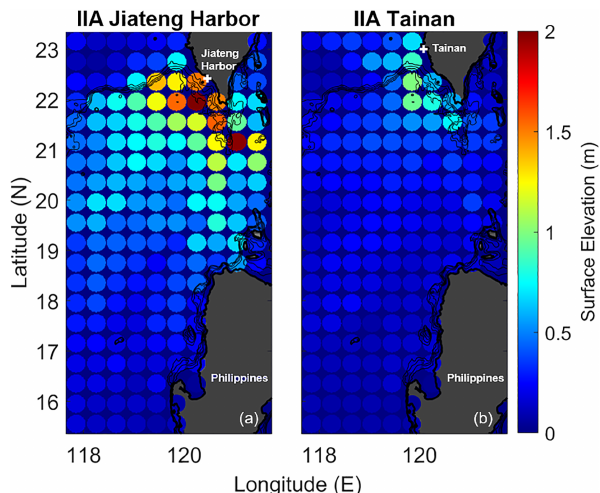
Figure 5. IIA results of the far-field region. Panels (a, b) show the IIA result of Jiateng Harbor and Tainan. The white crosses stand for the location of the study sites. The circles are the locations of unit- source tsunamis, with colors showing the value of maximum wave height recorded at the study site.